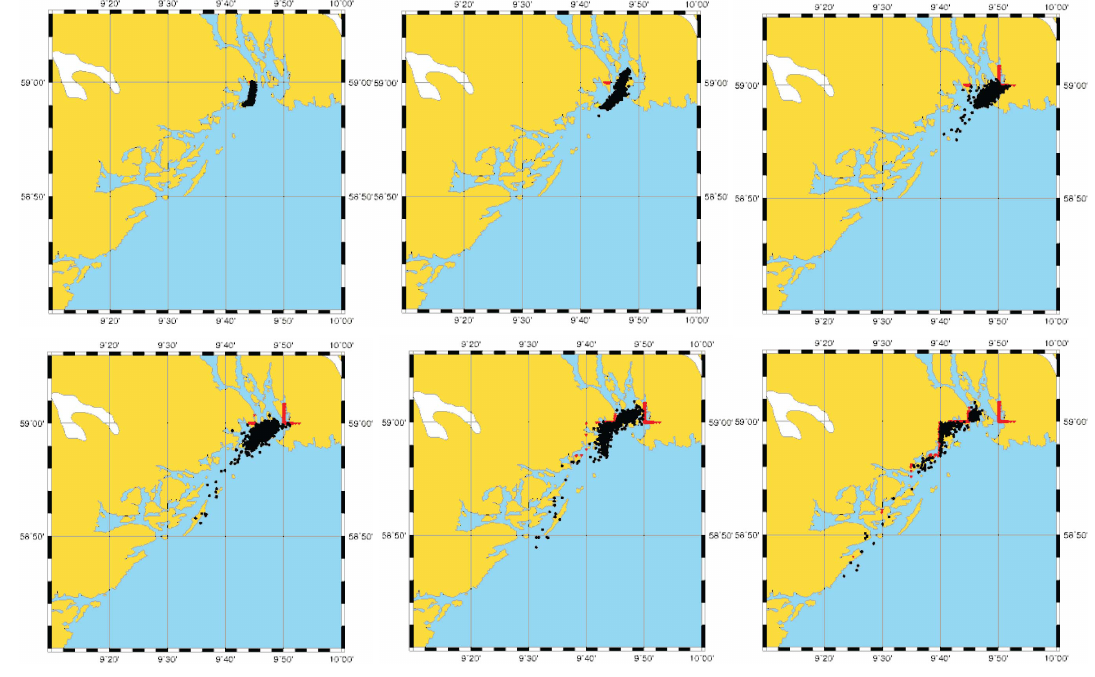
Fig. 9. Simulation of the “Full City” accident using the BSHdmod.L. The figure show the output 6, 12, 24, 36, 48, 60h after the initial release of